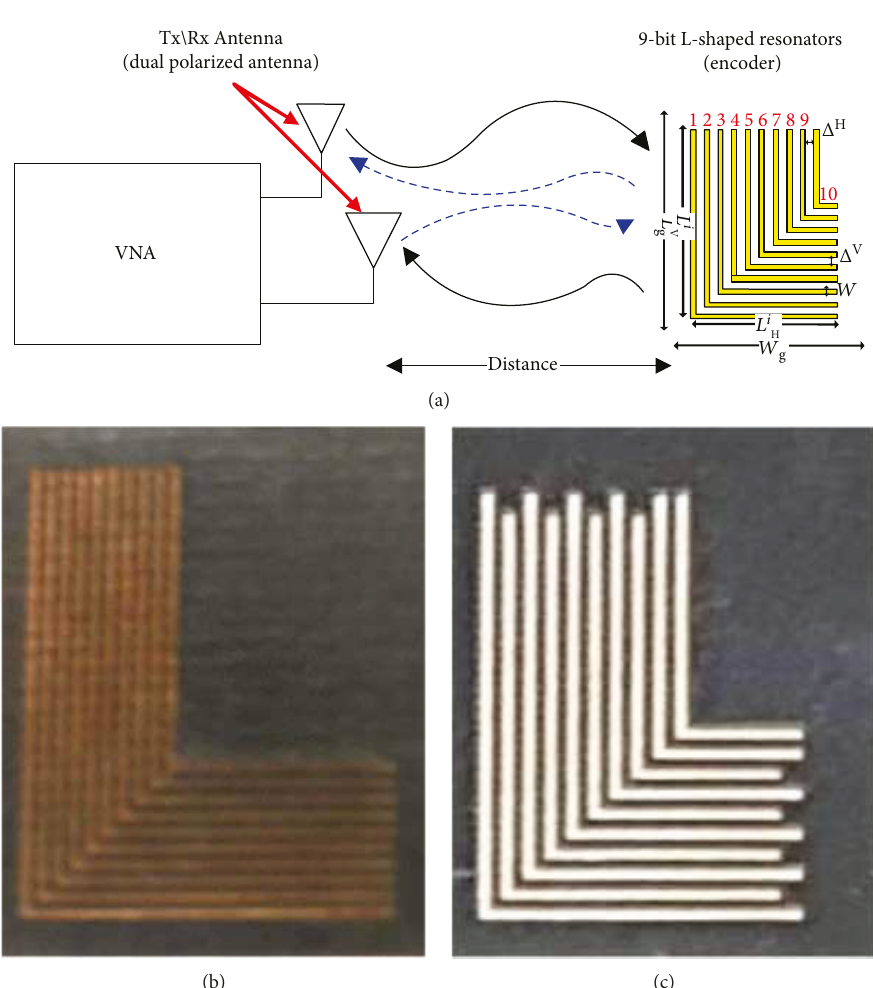
Figure 3: (a) Experimental setup of reader and backscattering tag, (b) fabricated chipless tag ID 111111111, and (c) fabricated chipless tag ID